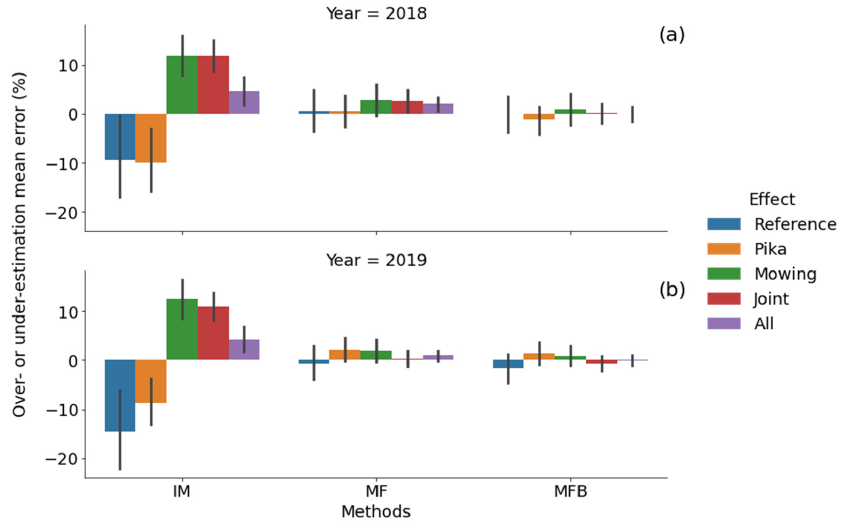
Figure 9. Comparison of over- and under-estimation mean error among the disturbance groups (IM is the initial model, MF is the mowing ratio modified model, MFB is the model modified by both mowing ratio and bare ground metrics): ( a ) AGB estimation errors in 2018; ( b ) AGB estimation errors in 2019.